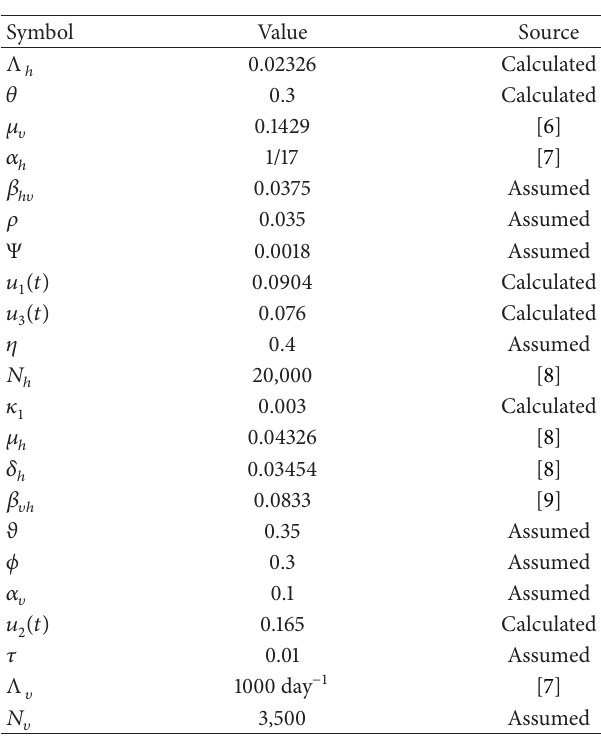
Table 11: Table for parameter values of the optimal malaria model.